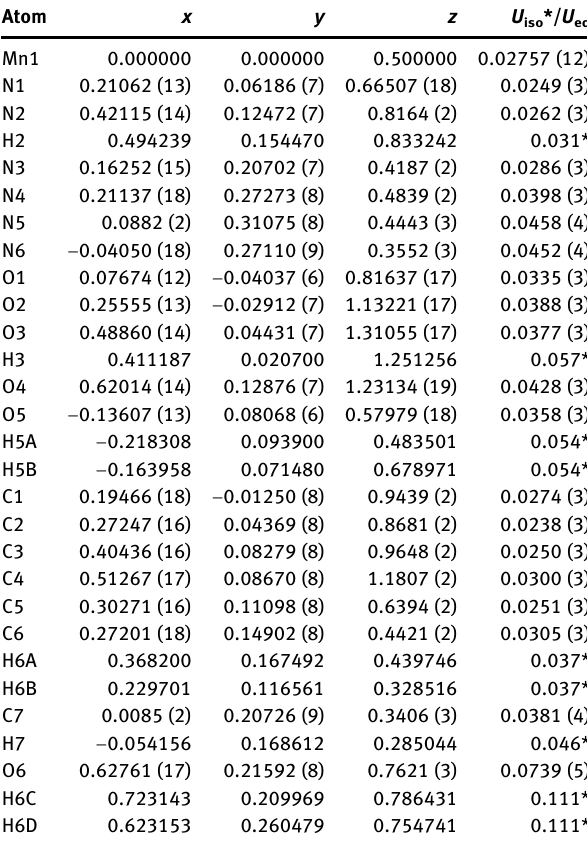
Table  : Fractional atomic coordinates and isotropic or equivalent isotropic displacement parameters (Å 